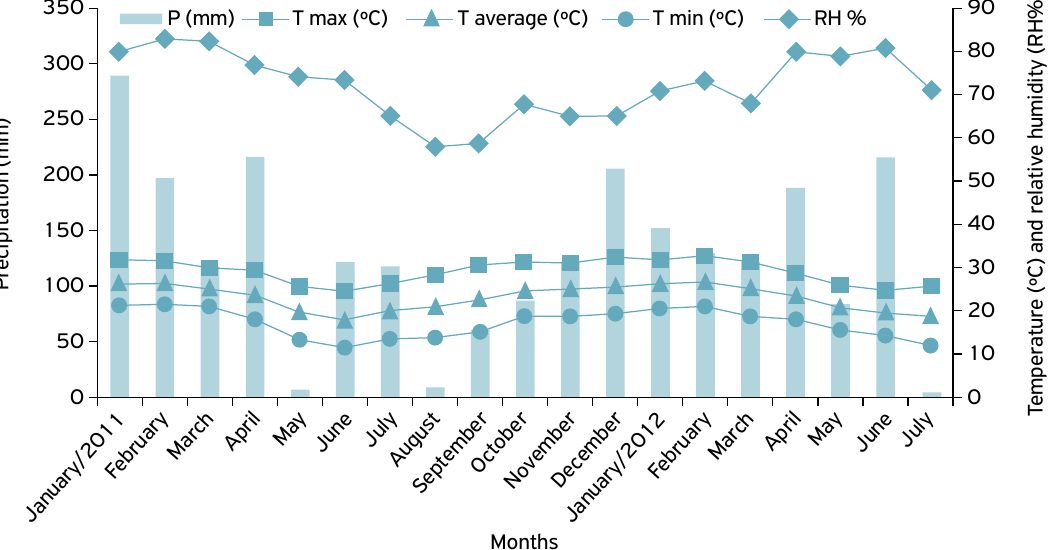
Figure 1. Precipitation (mm), maximum temperatures (T max. °C), minimum (T min. °C) and averages (T average °C) and relative humidity (RH%) from January 2011 to June 2012, Mato Grosso do Sul.